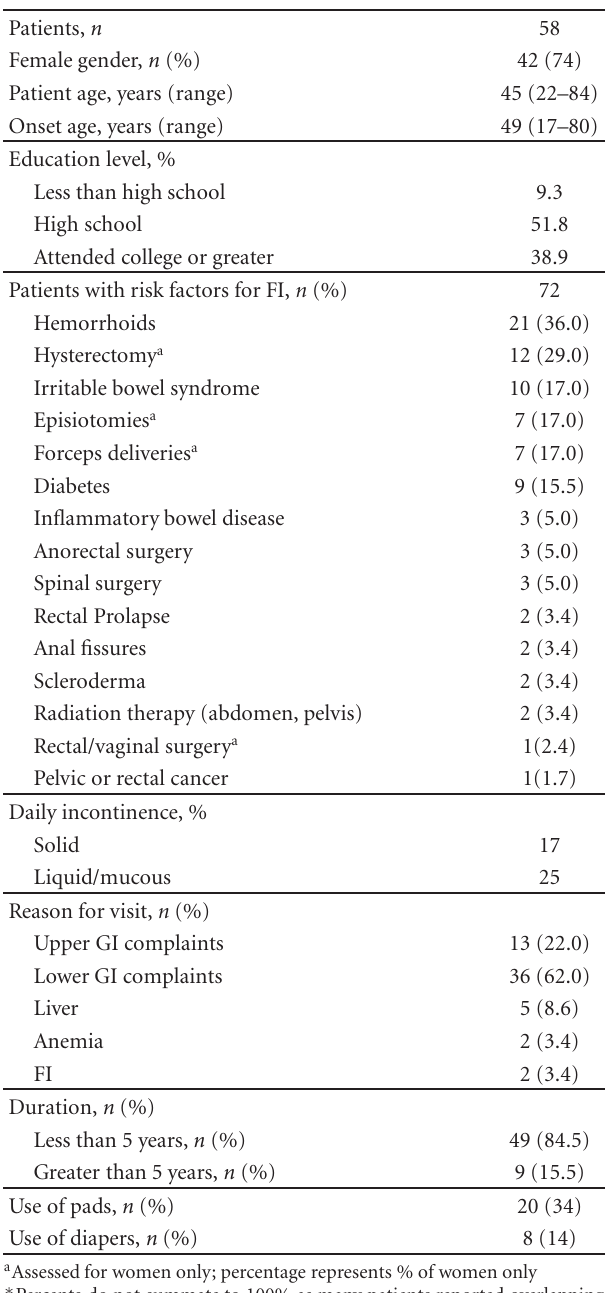
Table 1: Patient characteristics.